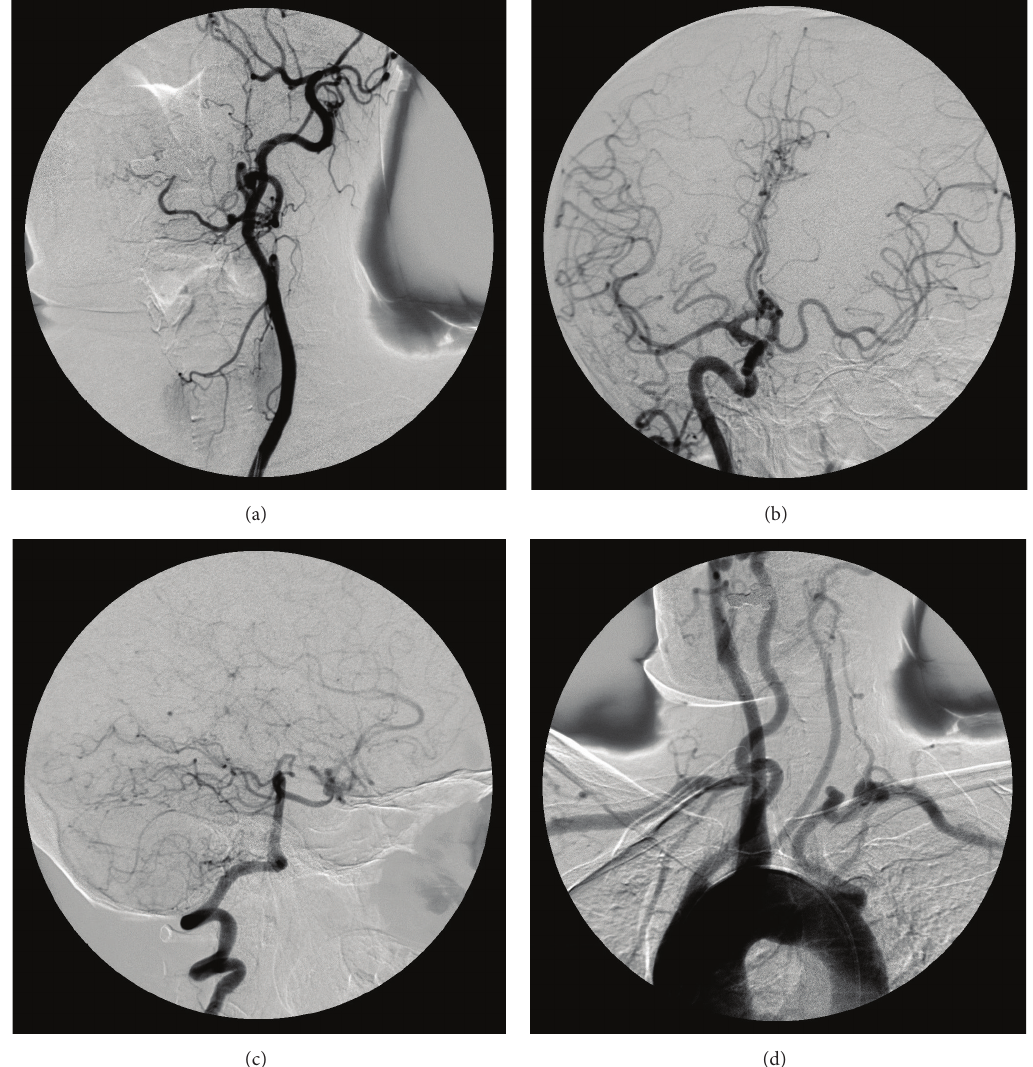
Figure 3: (a) After contrast injection to the left common carotid artery, the presumed (but absent) left ICA tract does not reveal any filling, while the left ECA and its branches are clearly visible. (b) At this Towne projection image, the filling of the left anterior cerebral and medial arteries via the patent anterior communicating artery is seen. (c) At this right lateral projection, vascular fillings of the left hemicranium with contrast via the posterior communicating artery following the injection of the vertebral artery are seen. (d) At arcus aortography, the right vertebral artery is seen as the first branch stemming from the aortic arch. The left common carotid artery caliber is substantially decreased. The left vertebral and subclavian arteries look